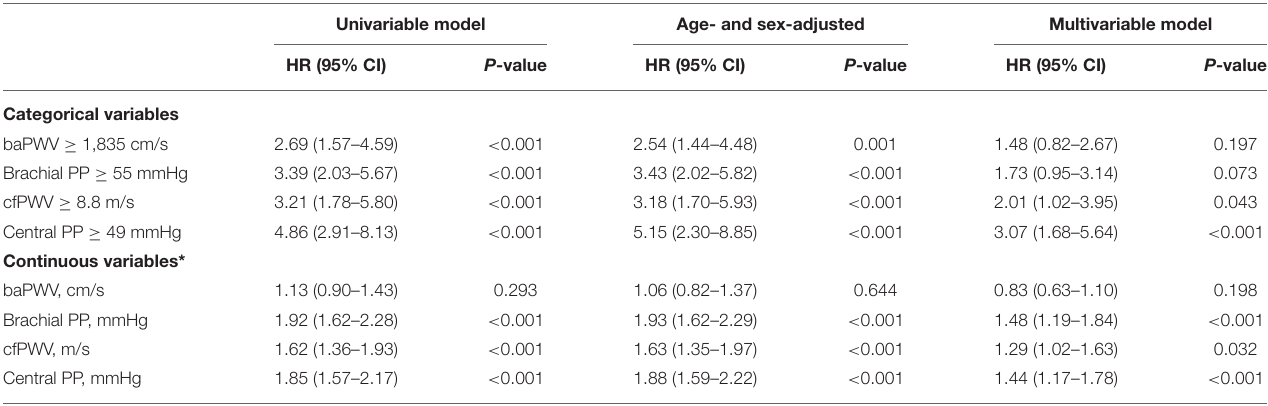
TABLE 3 | The association between arterial stiffness measures and incident heart